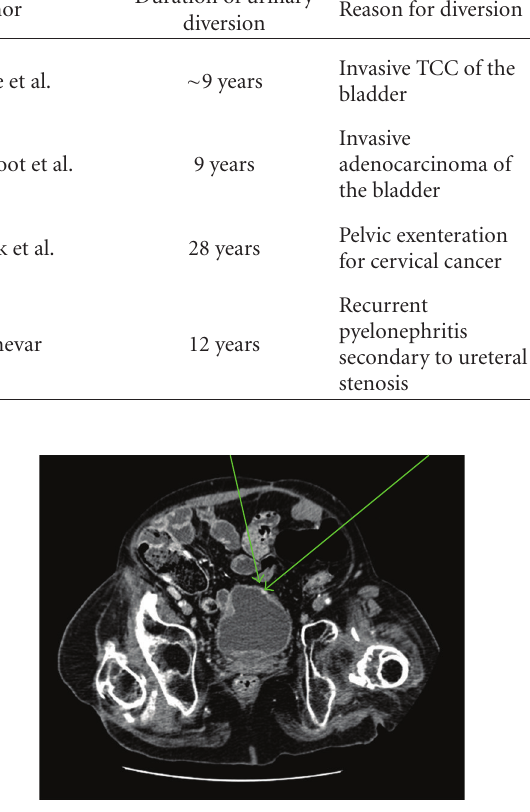
Figure 2: A high-powered histologic view of the carcinoid tumor. This tumor demonstrates the carcinoid tumor cell’s characteristic ovoid nuclei with scant cytoplasm along with a fibrovascular